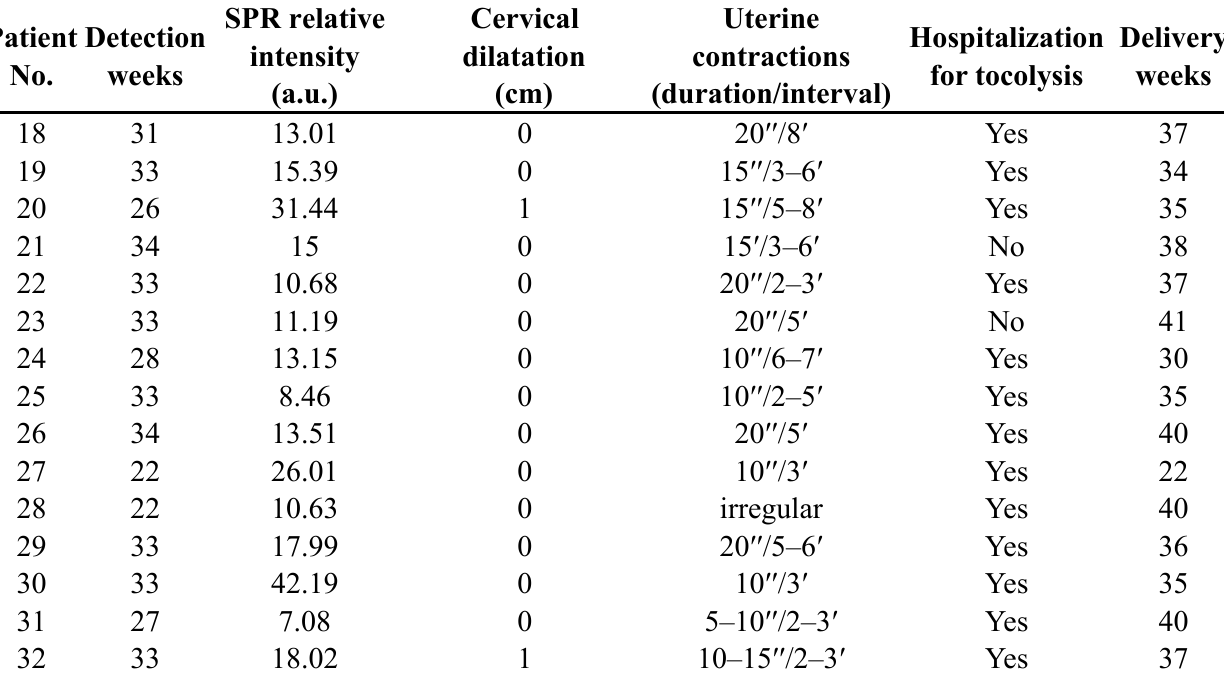
Figure 2. Sensorgram of a clinical sample from a pregnant woman at 33 gestational